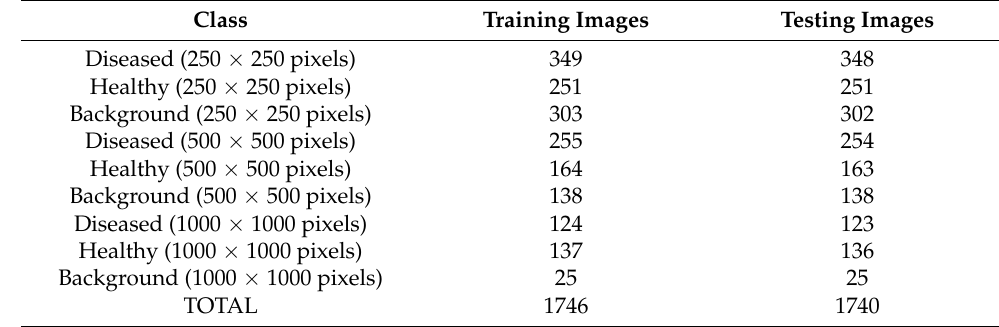
Table 1. Dataset distribution for training deep learning models for identifying diseased regions using tile